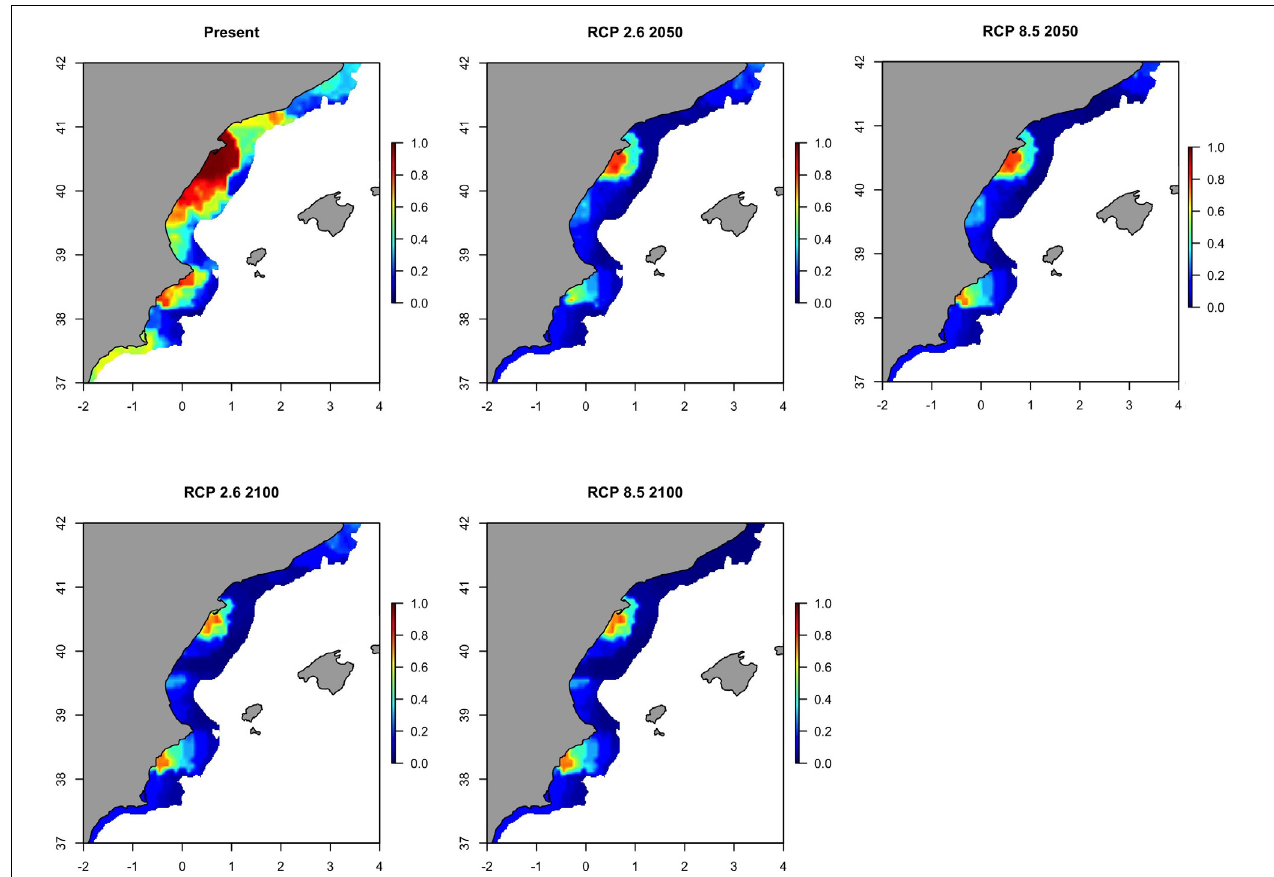
FIGURE 8 | Predicted probability of occurrence of the European sardine ( Sardina pilchardus ) in Geographical Sub-Area 06 for the present situation and using IPCC pathway scenarios obtained with RAC-BRT models.